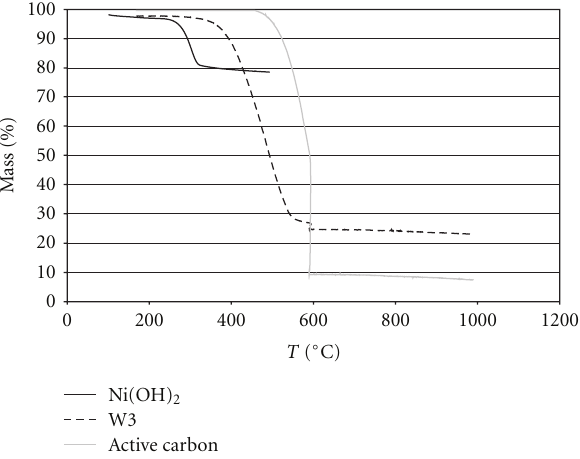
Figure 2: TGA curves of NiO, W3, and active